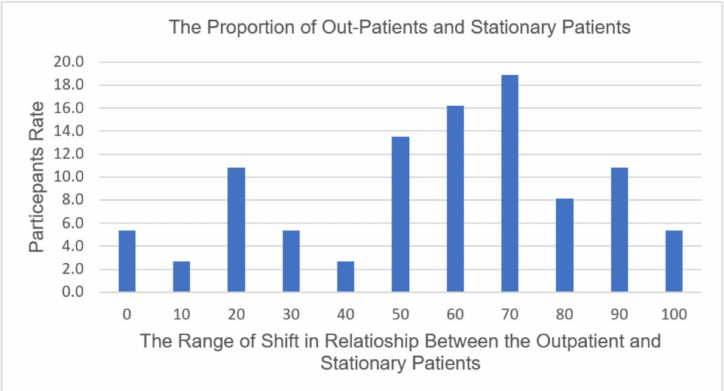
Figure 3. Shift in relationship between outpatients and stationary patients during COVID-19 crisis.